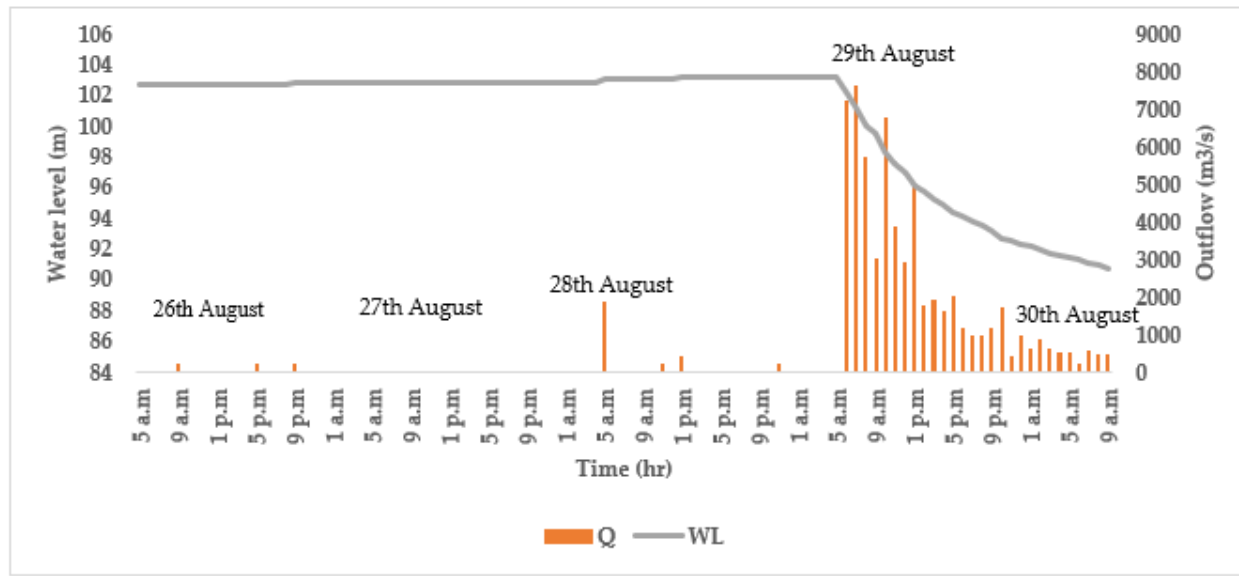
Figure 10. Observed dam water level and calculated out fl ow rate from 26 to 30 August 2018.